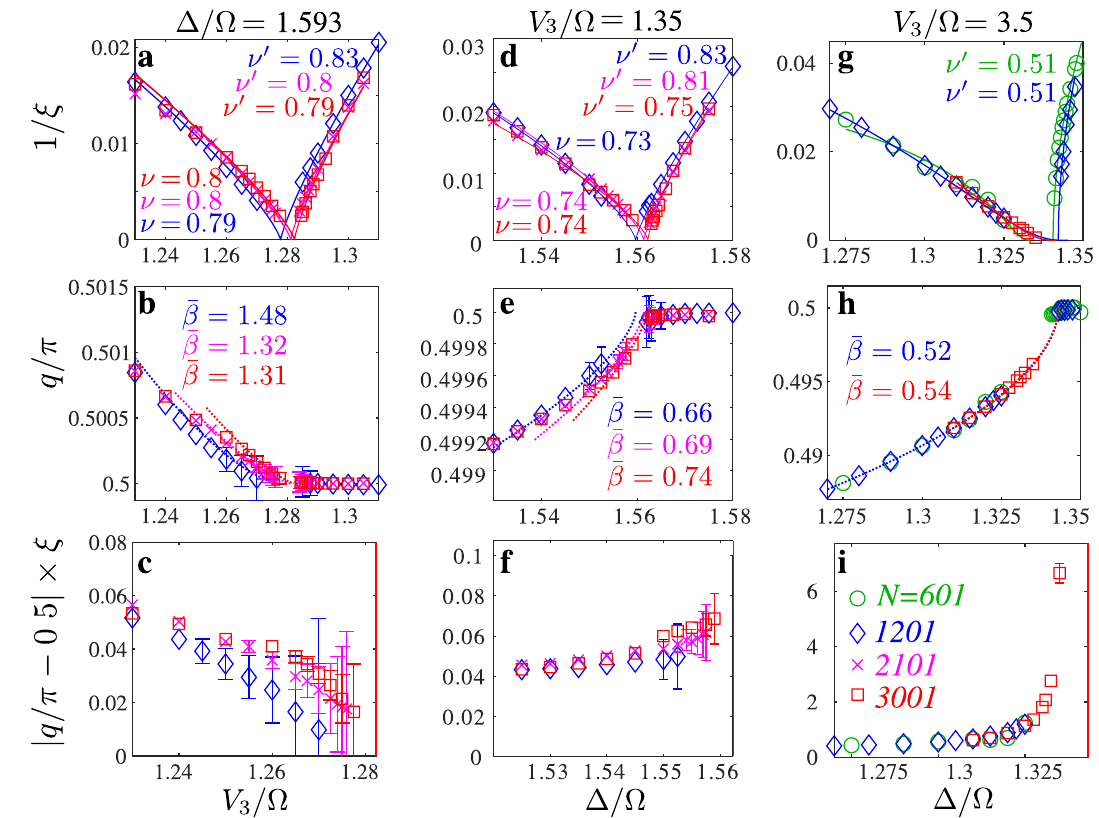
Fig. 5 Inverse correlation length 1/ ξ , wave vector q / π , and product ξ × ∣ π /2 − q ∣ along three different cuts across the transition. a – c Vertical cut through the Ashkin – Teller point at Δ / Ω = 1.593; d – f , g – i Horizontal cuts at V 3 / Ω = 1.35 and V 3 / Ω = 3.5, respectively. Inside the p = 4 phase, the correlation length is fi tted with a power law with critical exponent ν 0 . In the disordered phase, the correlation length is fi tted either with a power law ffiffiffiffiffiffiffiffiffiffiffiffiffiffiffi p (cid:2) g Þ ( g ), where g is the coordinate along the cut. The wave vector q is fi tted with a with critical exponent ν ( a , d ) or with the KT form ξ / exp ð C = g KT power law with exponent (cid:1) β (dotted lines). Wave vectors q are de fi ned within the error bars ± πξ / N 2 ; and ξ × ∣ π /2 − q ∣ is de fi ned up to ± πξ 2 / N 2 . For points without error bars, the error bar is smaller than the size of the symbol. In the lower panels, the red lines indicate the boundary of the ordered